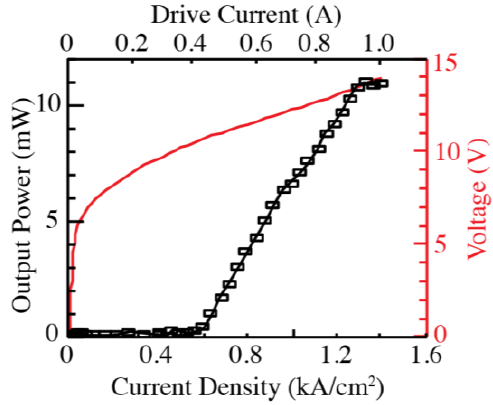
Figure 3. Pulsed output power and voltage vs. injection current density and current at 20 °C of an integrated DFB QCL of Design D with III-V tapers on both sides. Light is collected from the polished passive SONOI facet.